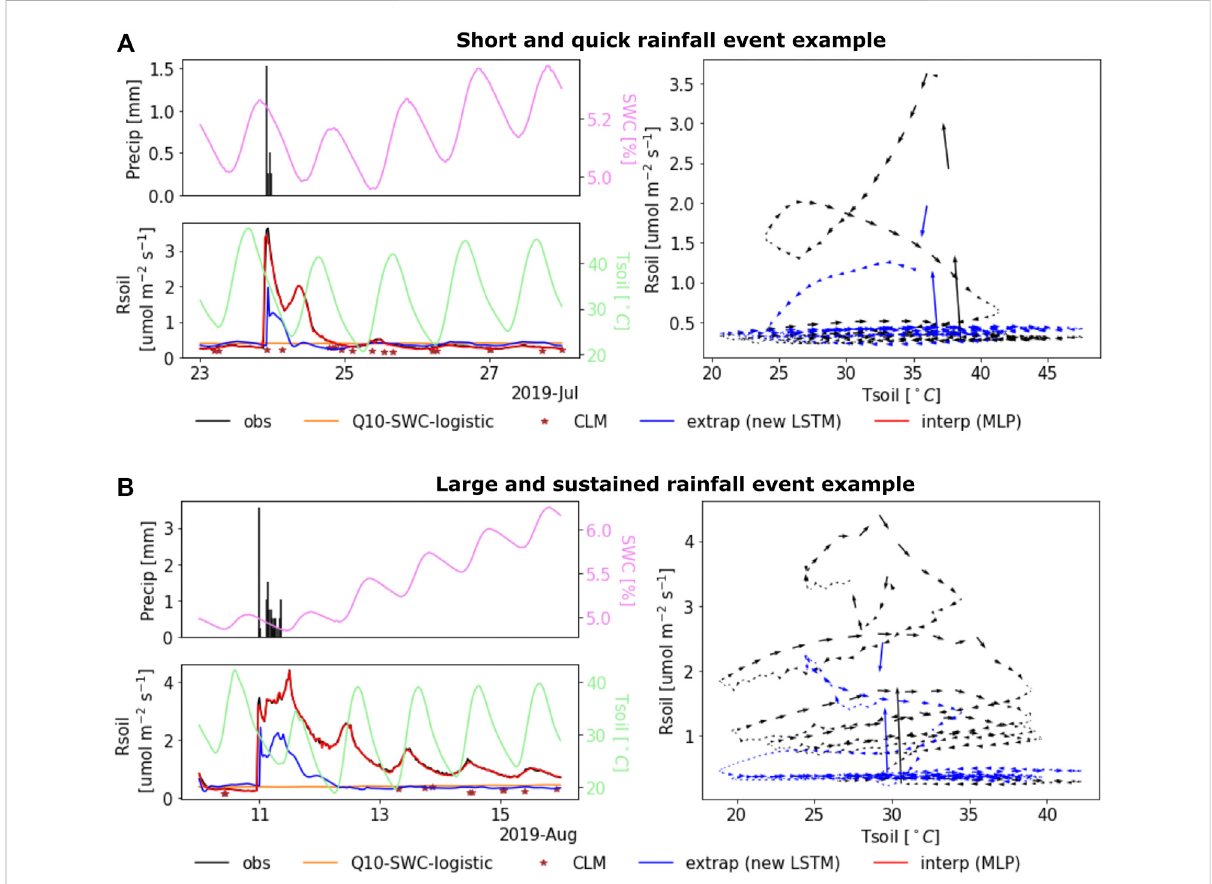
FIGURE 6 The match between modeled and observed Rsoil during and after two rainfall events. (A) Performance of the best interpolation and extrapolationDLmodels (Figure 5),theQ10-SWC-logistic model,and theCLMsimulationfor ashortand quickrainfallevent. (B) Performanceofthe best interpolation and extrapolation DL models (Figure 5), the Q10-SWC model, and the CLM simulation for a long and sustained rainfall